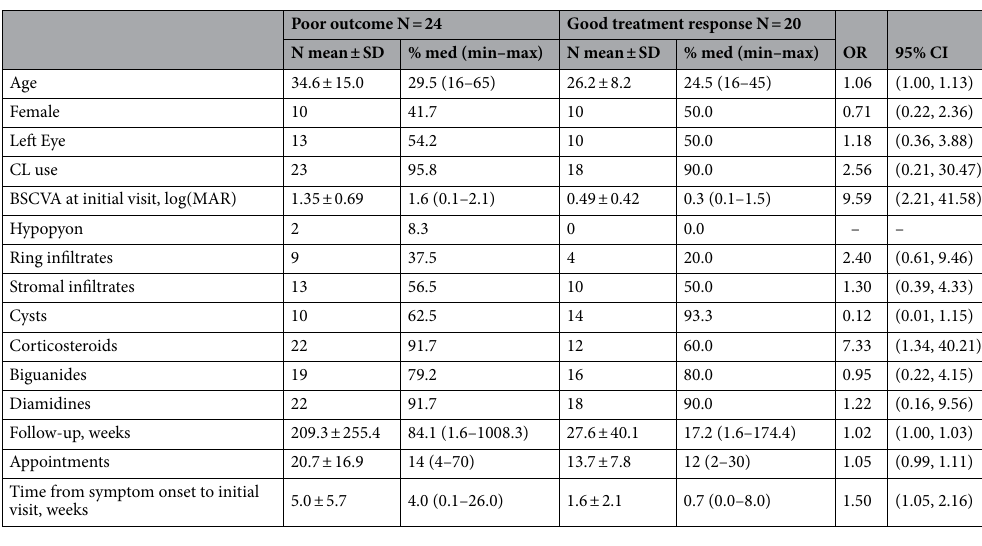
Table 5. Univariable logistic regression analyses for ‘poor outcome’. BSCVA best spectacle-corrected visual acuity, CL contact lens, log(MAR): logarithm of the minimum angle of resolution, max maximum, med median, min minimum, N absolute number, SD standard deviation, OR odds ratio, CI confidence interval.